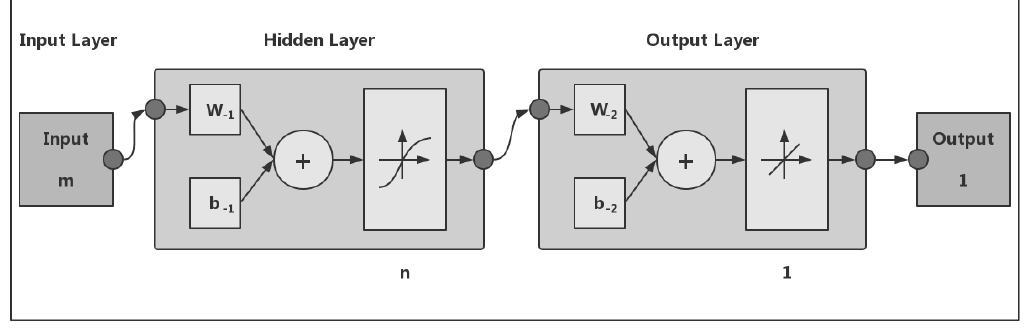
Figure 4. BP neural network model structure.